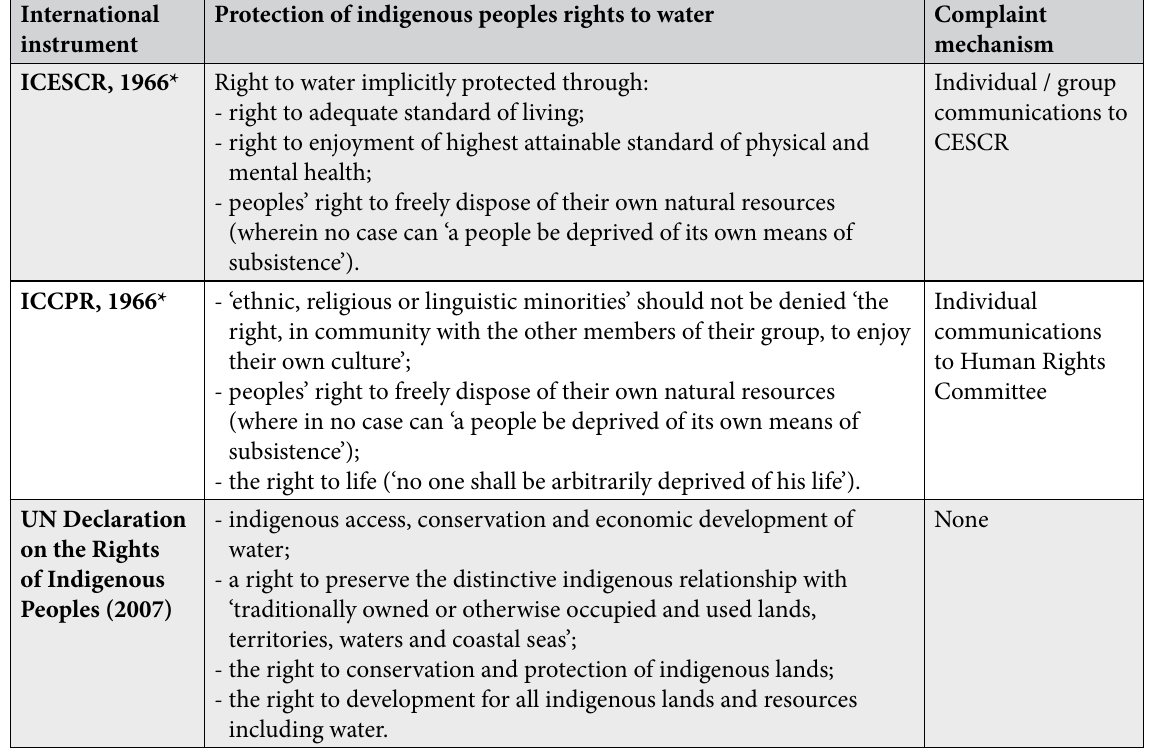
Relevant provisions on the right to and ownership of water of indigenous